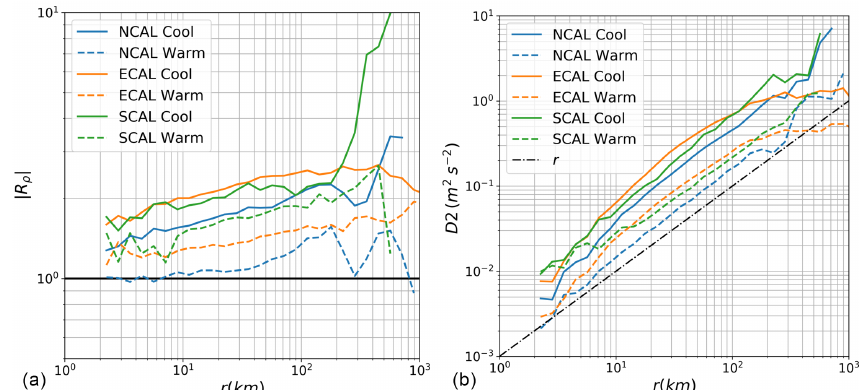
Figure 8. Absolute density ratio | R ρ | (b) and structure function of available potential energy (a) as a function of the separation vector r for the regions NCAL (blue), ECAL (orange) and SCAL (green). Seasonality is shown between cool (June to November, solid curves) and warm (December to May, dashed curves) seasons. In panel (a) , the black horizontal line corresponds to dominates density variation. In panel (b) , the dashed–dotted black line correspond to the power law r 1